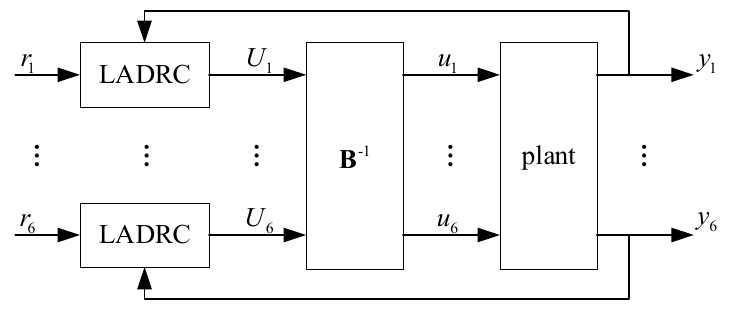
Figure 6. The diagram of LADRC for a MIMO system.